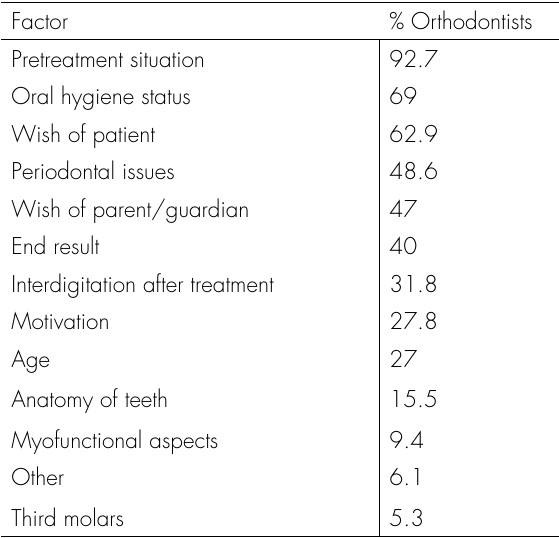
Table IX. Factors that influence treatment type by orthodontists.